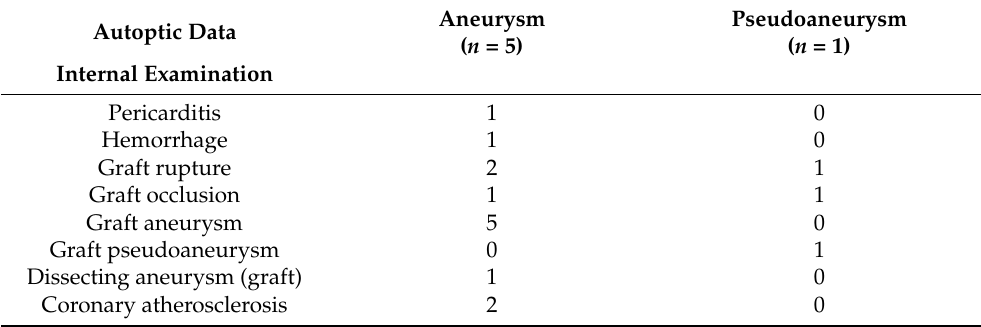
Table 7. The table shows the main autopsy findings in the cases analyzed. Both macroscopic and histological findings in aneurysm and pseudoaneurysm cases were